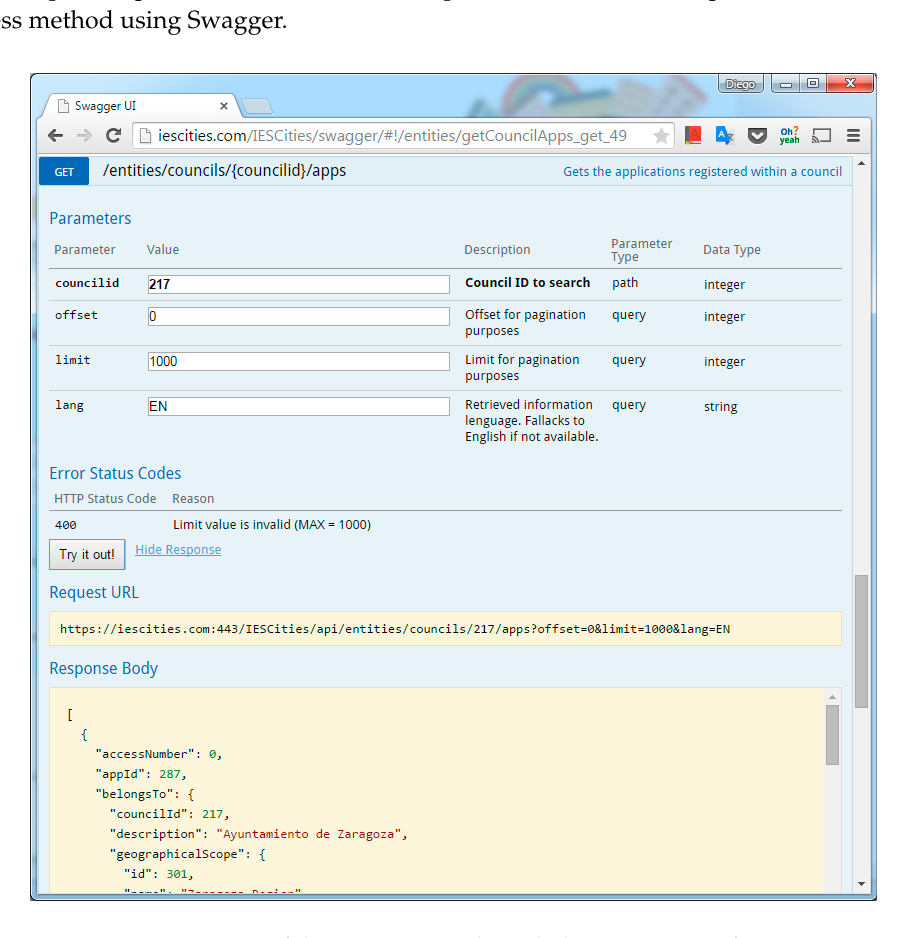
Figure 4. RESTful API invocation through the Swagger interface.